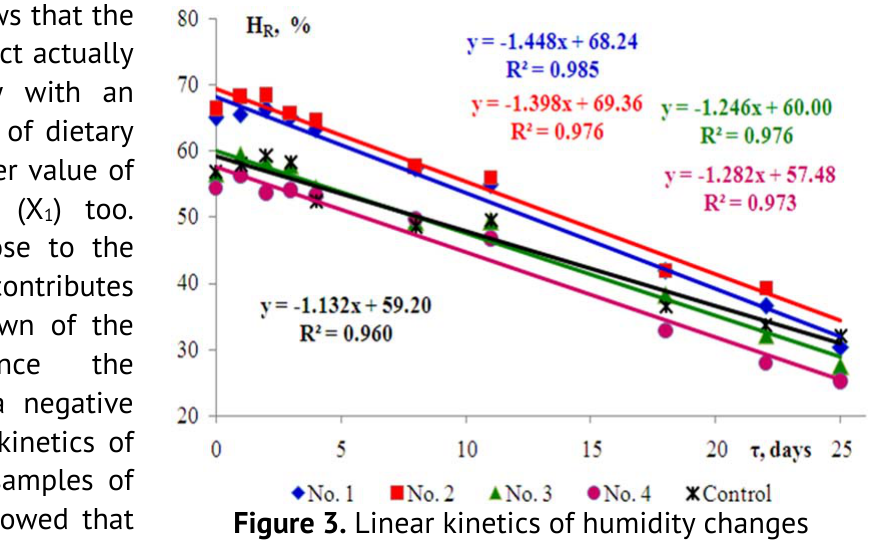
Figure 3. Linear kinetics of humidity